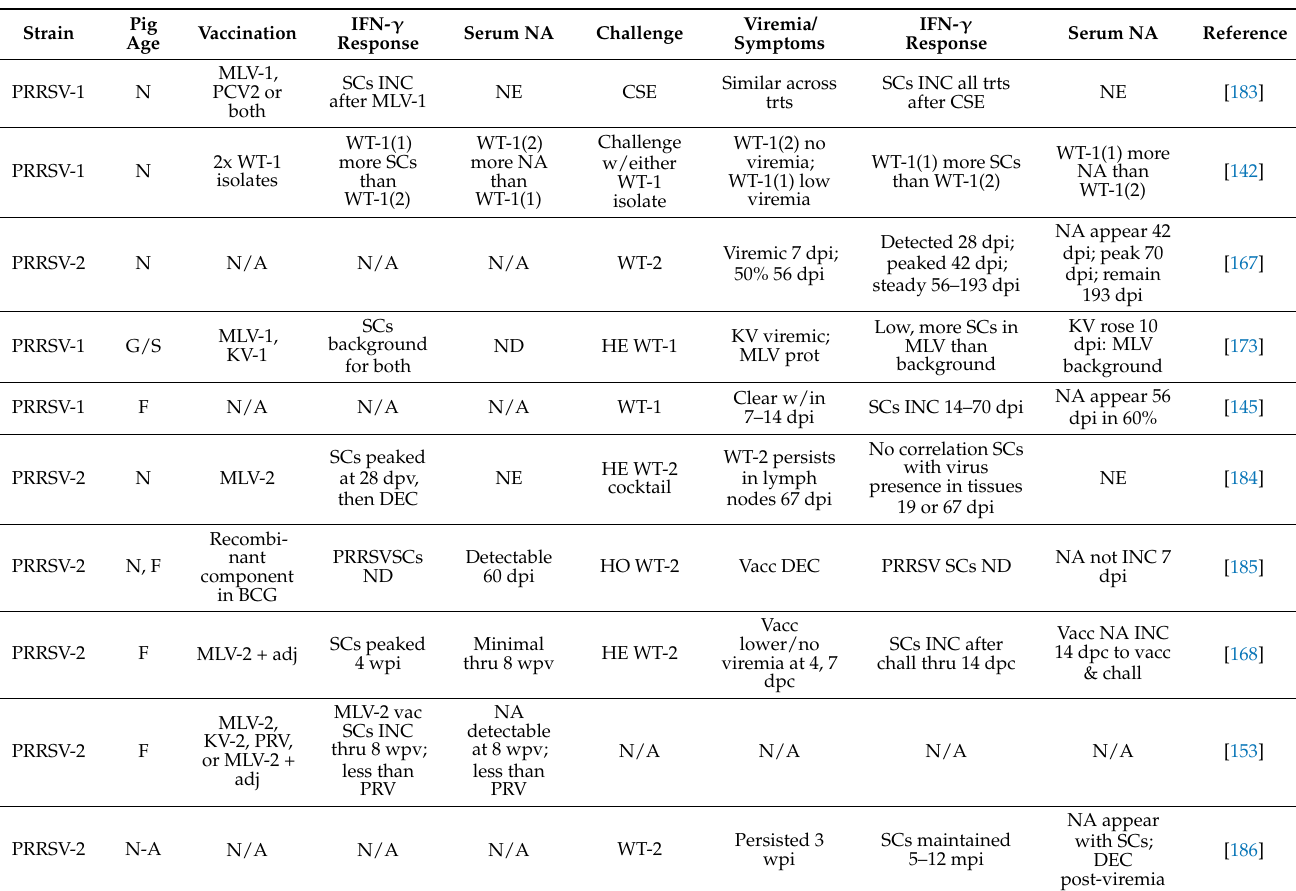
Table Abbreviations: N—Nursery (2 weeks+), A—adult, F—finishing (8 weeks+), G/S—gilt/sow, CPD—Codon- pair deoptimization, HO—homologous, HE—heterologous, KV—killed virus, dp—days post,